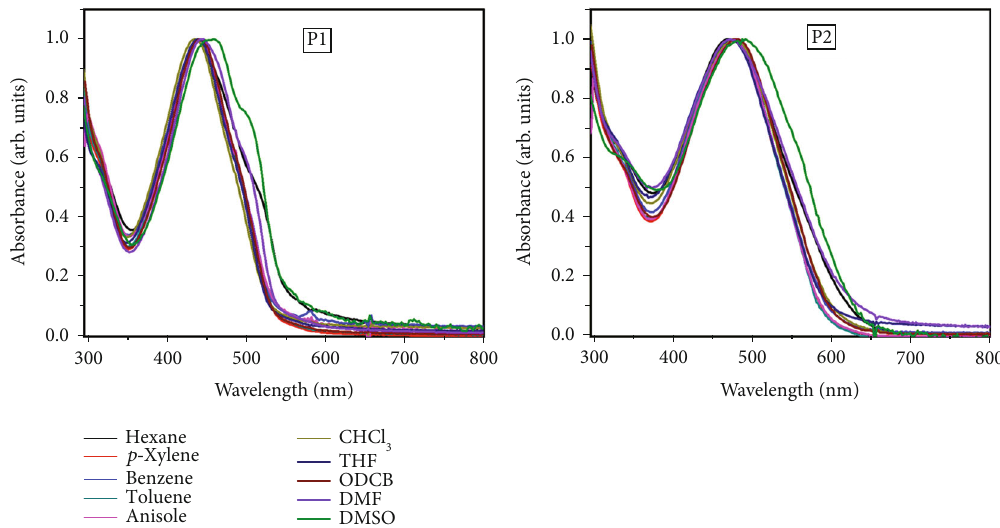
Figure 6: UV-Vis absorption spectra of P1 and P2 as dilute solutions in di ff erent solvents. Note that P2 has poor solubility in hexane, and the upper, clear portion of a saturated P2 solution in hexane was collected and used for measurement. Also, note that due to the very poor solubility of P1 and P2 in DMF and the insolubility of P1 and P2 in DMSO, these solutions were prepared by adding a very small amount of concentrated CHCl stock solution of P1 or P2 to respective solvents. 3 Table 1: Absorption maxima of P1 and P2 as dilute solutions in di ff erent solvents.